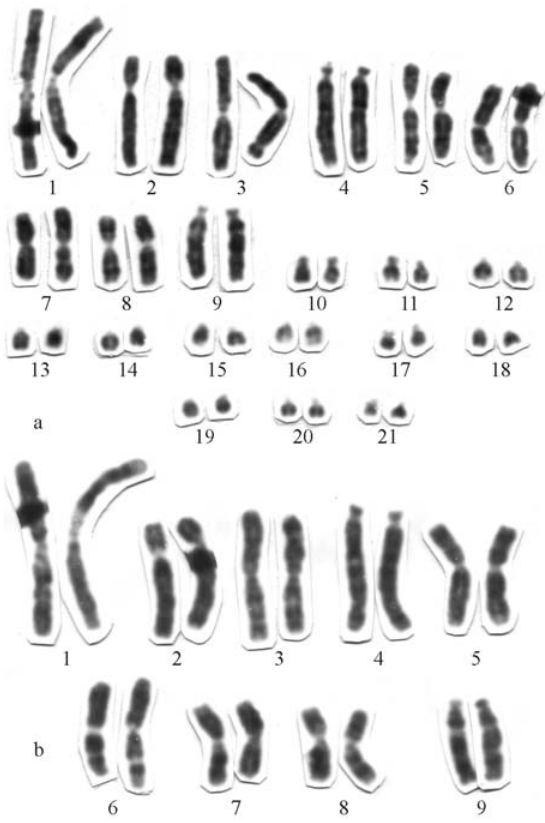
Figure 8 - Karyotypes of Tretioscincus oriximinensis (2n = 42,18M+24m). (a) complete karyotype showing some minor R-bands (b) RBG-banding of the macrochromosomes